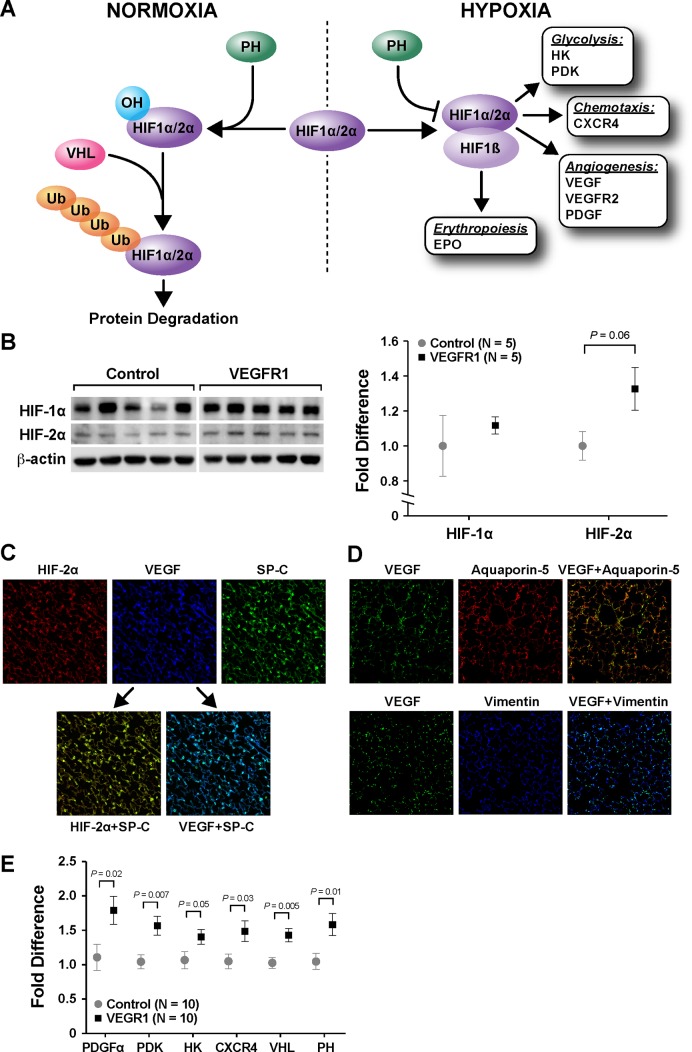
VEGFR1 treatment activated the hypoxic response after left PNX.Regulation of hypoxia-induced factor (HIF) is demonstrated (A). In a normoxic condition, HIF is hydroxylated by prolyl hydroxylase (PH), ubiquitinated by von-Hippel Lindau (VHL), and destined for degradation. In a hypoxic condition, HIF is stabilized, which leads to dimerization with HIF1β and activation of multiple signaling pathways. VEGFR1 treatment increased the expression of HIF2α in the lung (B). On immunohistochemistry (IHC), both VEGF and HIF2α colocalized with SP-C (C), indicating that they were produced in alveolar epithelial cell (AEC) type II. Furthermore, VEGF did not colocalize with Aquaporin-5, a marker for AEC type I, or Vimentin, a marker for fibroblasts (D). On qPCR, VEGFR1-treated lung also displayed increased expression of many HIF-regulated factors, including platelet-derived growth factor α (PDGFα), pyruvate dehydrogenase kinase (PDK), hexose kinase (HK), and CXC chemokine receptor 4 (CXCR4), as well as factors involved in HIF degradation, including VHL and PH (E). Data are expressed as mean ± standard error (SE).